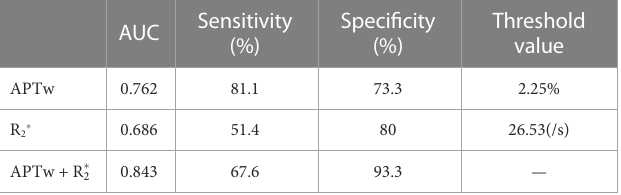
TABLE 5 Diagnostic ef fi cacy of each parameter.